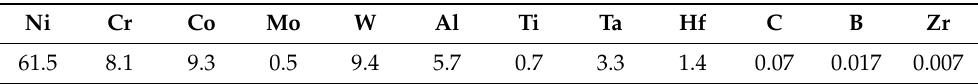
Table 1. Composition of MAR M247LC in wt.%.